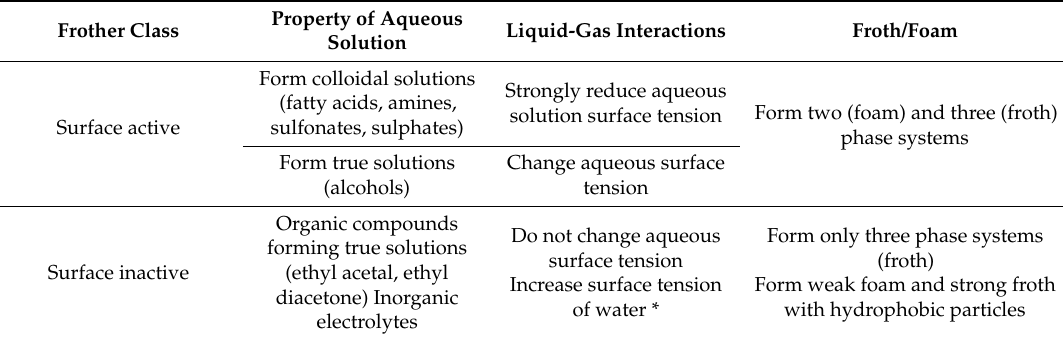
Table 8. Classification of frothers according to their surface activity in water at concentrations applied in flotation (after [31]).